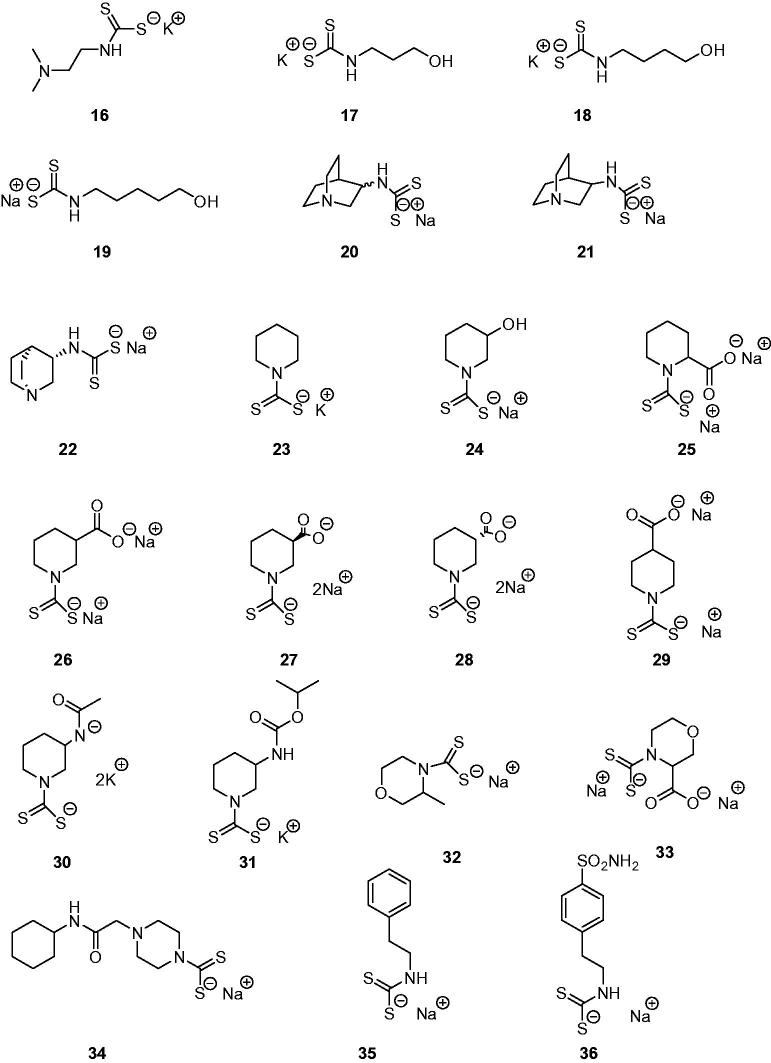
Dithiocarbamates (DTCs) 16–36 investigated as CA inhibitors1,2.